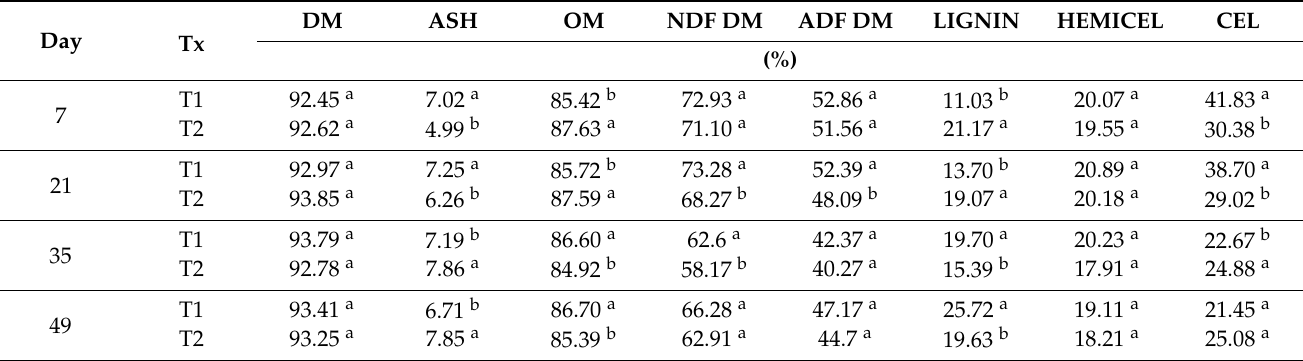
Table 3. Fecal fiber composition of rabbits fed with diets containing untreated sorghum (T1) and sorghum transformed by SSF with T. maxima CU1 and P. sanguineus CS2 (T2).